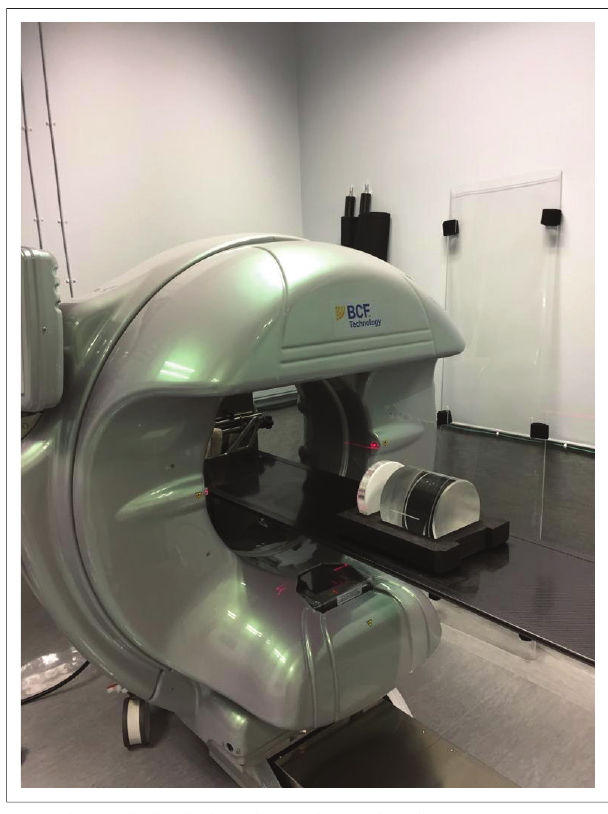
FIGURE 1: The high-definition volumetric computed tomography unit on wheels in a spare theatre converted to an imaging suite. The gantry rotates around the patient represented by the imaging phantom in this